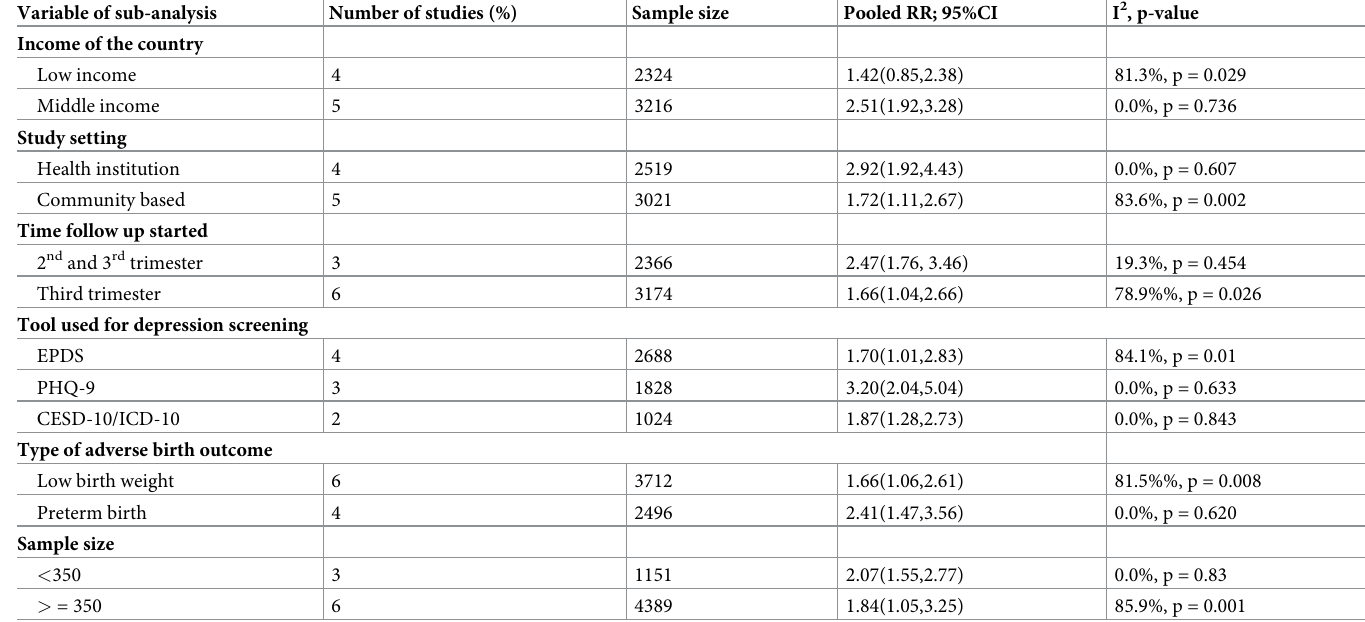
Table 5. Sub-analysis of the association of antenatal depression with adverse birth outcomes in the low- and middle-income countries (N = 9, in the year 2007– 2017), (random effect model). Variable of